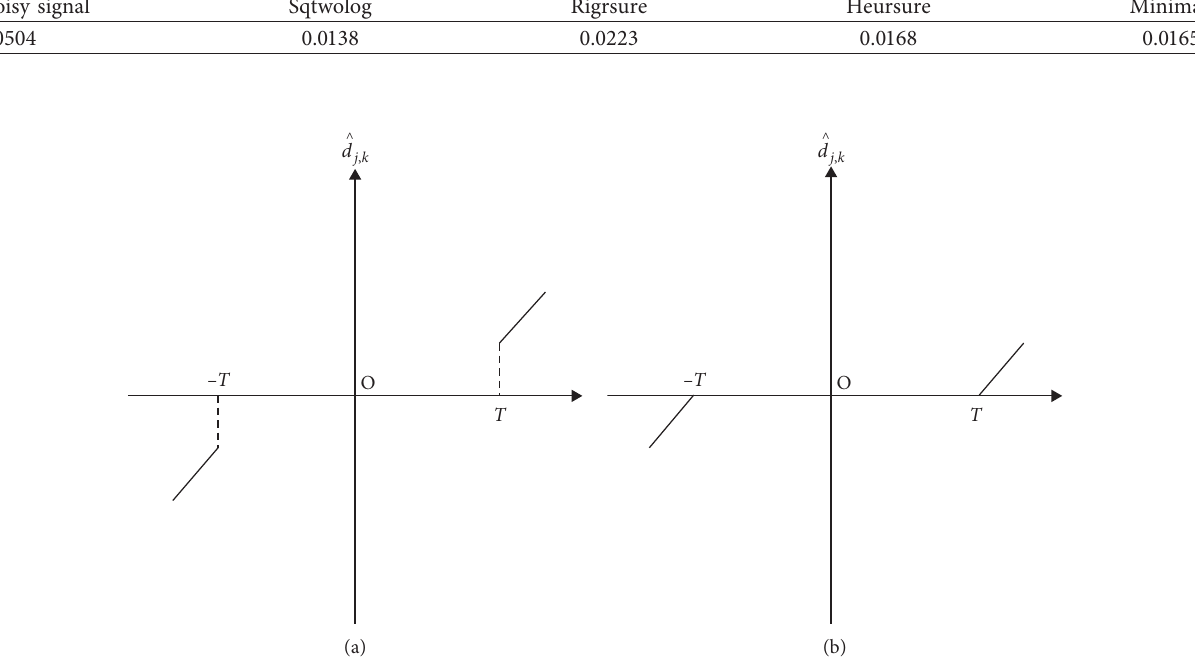
Table 1: Standard deviation of noisy signal and different threshold after noise reduction [18]. Noisy signal